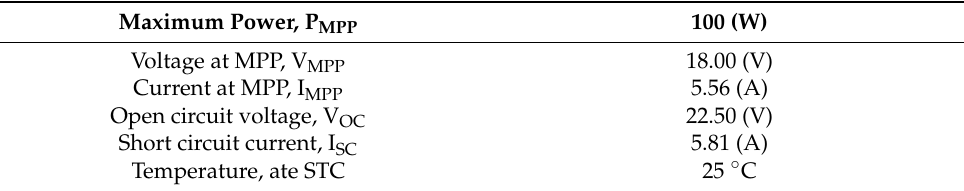
Figure 7. Photograph of the experimental setup of the solar power system. Table 1. DOKIO DFSP-100M PV Module Characteristics.